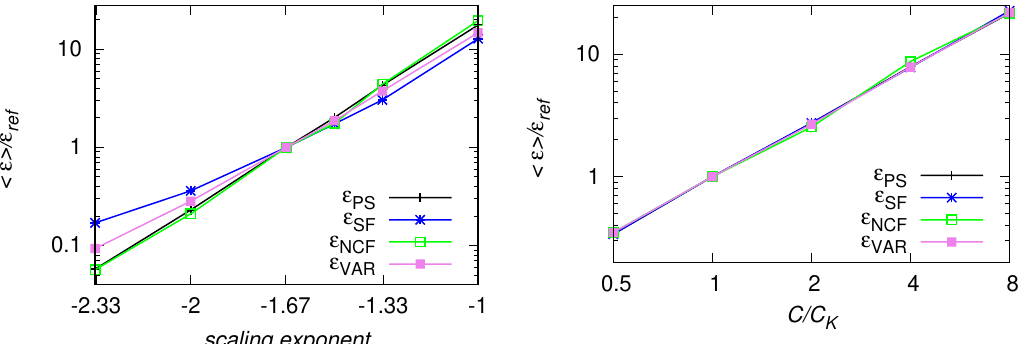
Figure 19. Mean of EDR estimates for artificial signals which deviate from the − 5/3 scaling (left panel) or with deviations from the standard value of the Kolmogorov’s constant C K ≈